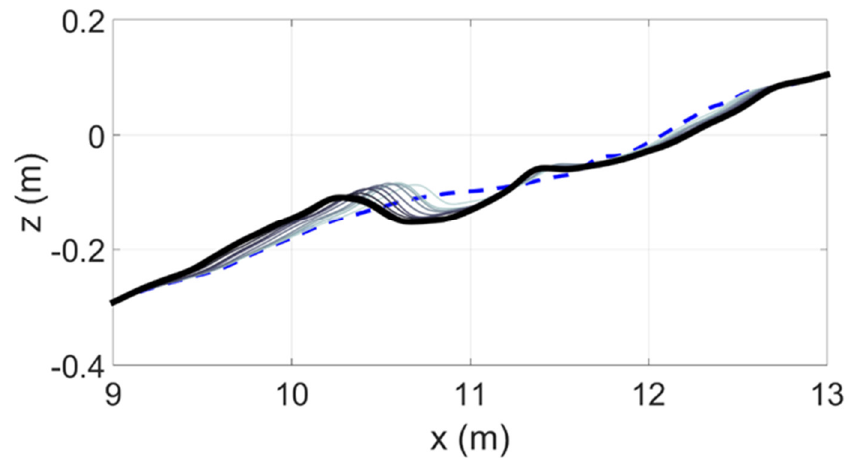
Figure 2. Profile evolution for the erosive wave case A. Initial (dashed blue), intermediate (thin grey) and final at t = 22 h (thick black) profiles. Note that small-scale sand ripples that are not resolved by the transport calculations have been filtered out from the profiles.